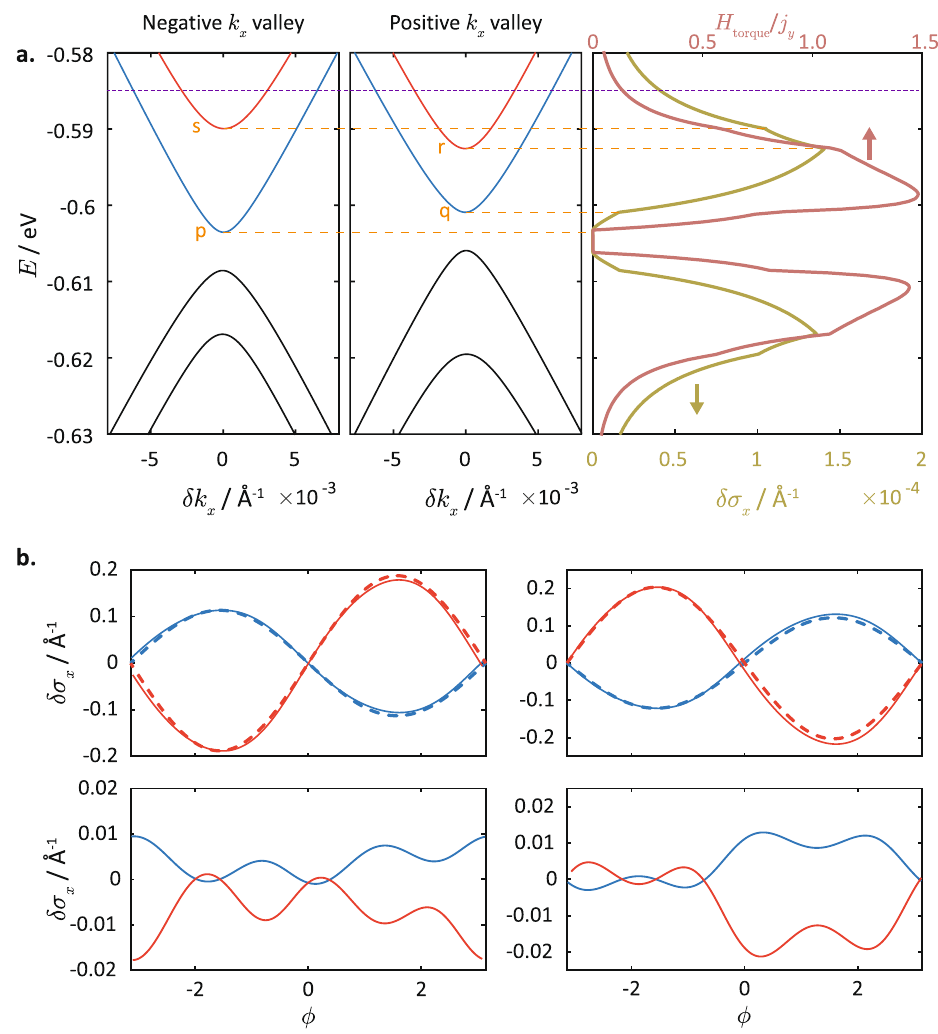
Figure 6. Bandstructure and spin accumulation in strained silicene. ( a ) The bandstructures at δ k y = 0 around the Dirac point in (left) the negative k x valley and (center) positive k x valley in strained silicene, with strain magnitude γ = 1.1 and strain direction α = 2 , coupled to an in-plane magnetization M x = 5 meV, and electric field of E z = 8 meV. The right plot shows the spin accumulation δσ z , and the spin torque efficiency, i.e., the ratio of the effective magnetic field due to the torque exerted by the spin accumulation to the current density. ( b ) The solid lines in the top plots show the δσ z for the bands with the corresponding plot colours in ( a ), for electron energy E = − 0.585 eV. For comparison, we plotted the sinusoidal sin φ curves (dotted) to show the asymmetry of the δσ z -dependence with variation in φ . The bottom plots show δσ z after subtracting away off the antisymmetric sin φ contribution, which clearly reveal the sign of the net spin